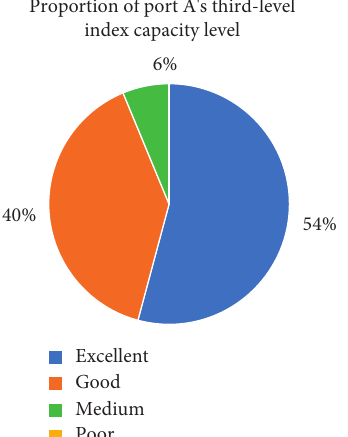
Figure 4: Proportion of tertiary index capacity level of Port